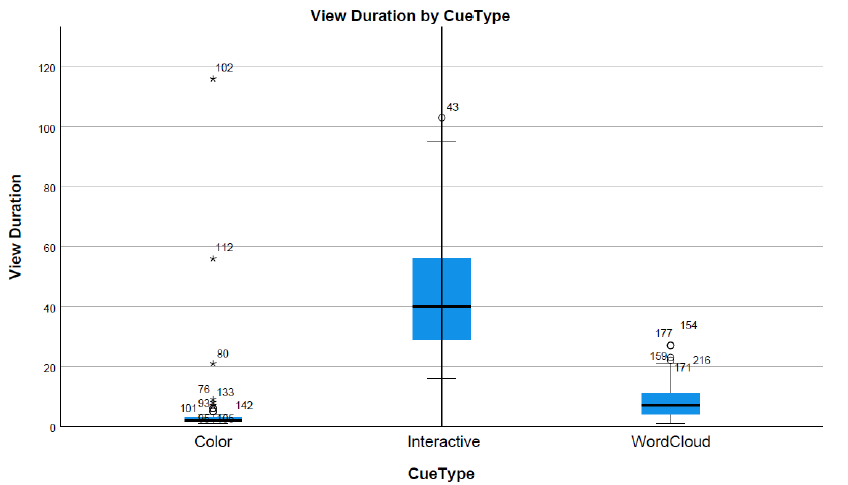
Figure 11. The viewing duration in seconds of the three cue types Color and Icon Cue , Interactive Test Cue , and WordCloud Cue